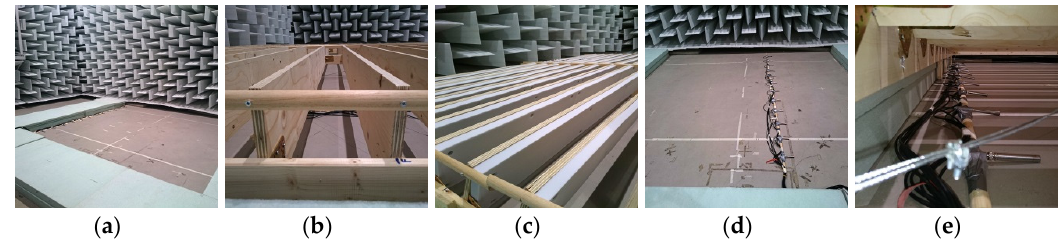
Figure 2. ( a ) The blank floor of the semi ‐ anechoic room simulating the plain facade; ( b ) the traditional shading system; ( c ) the sound absorbing louvres; ( d ) the 12 ‐ microphones array used in the measurements without the shading system model; and ( e ) the microphones placed on the plane below the model.